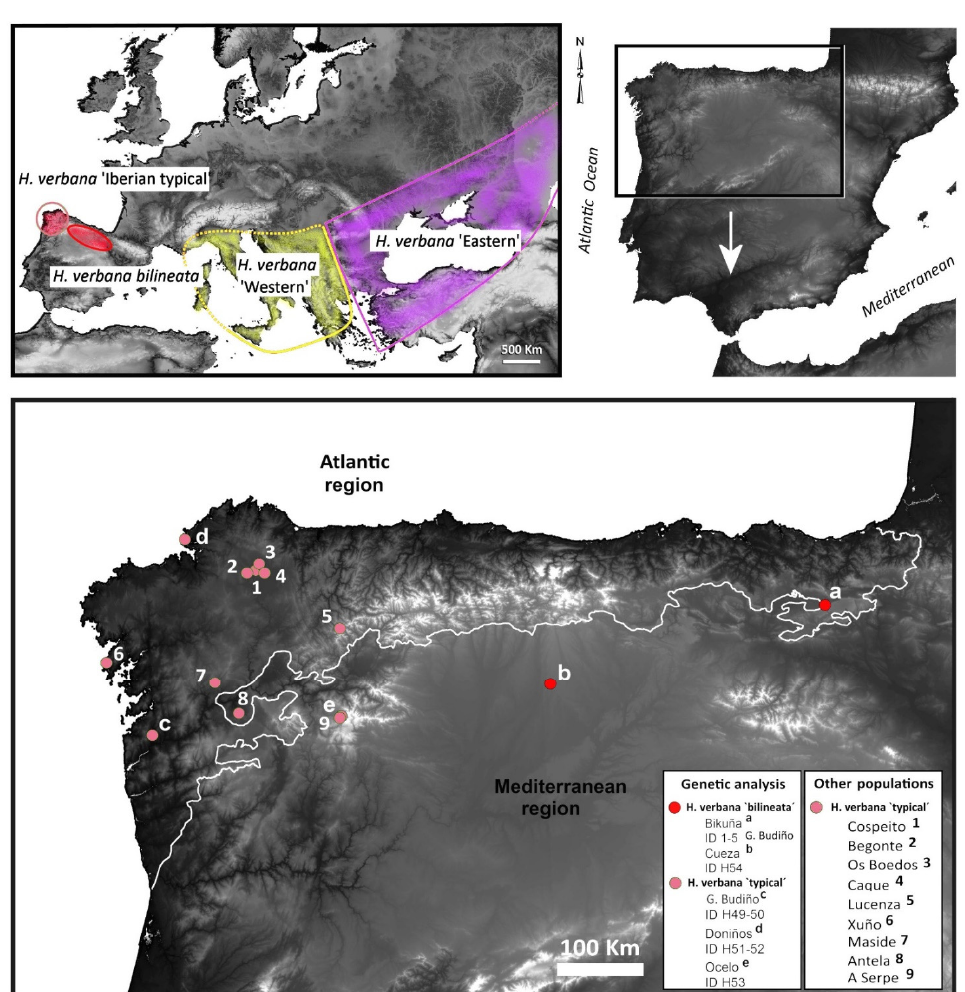
Figure 1. Geographical distribution of Hirudo verbana in Europe (top left corner) and in Iberian Peninsula, showing genetic-studied populations (a–e) and others (1–9) (bottom) [Elevation map SRTM 90 m]. Table 1. Location of studied Spanish samples used in this analysis with combined COI and 12S mt markers.